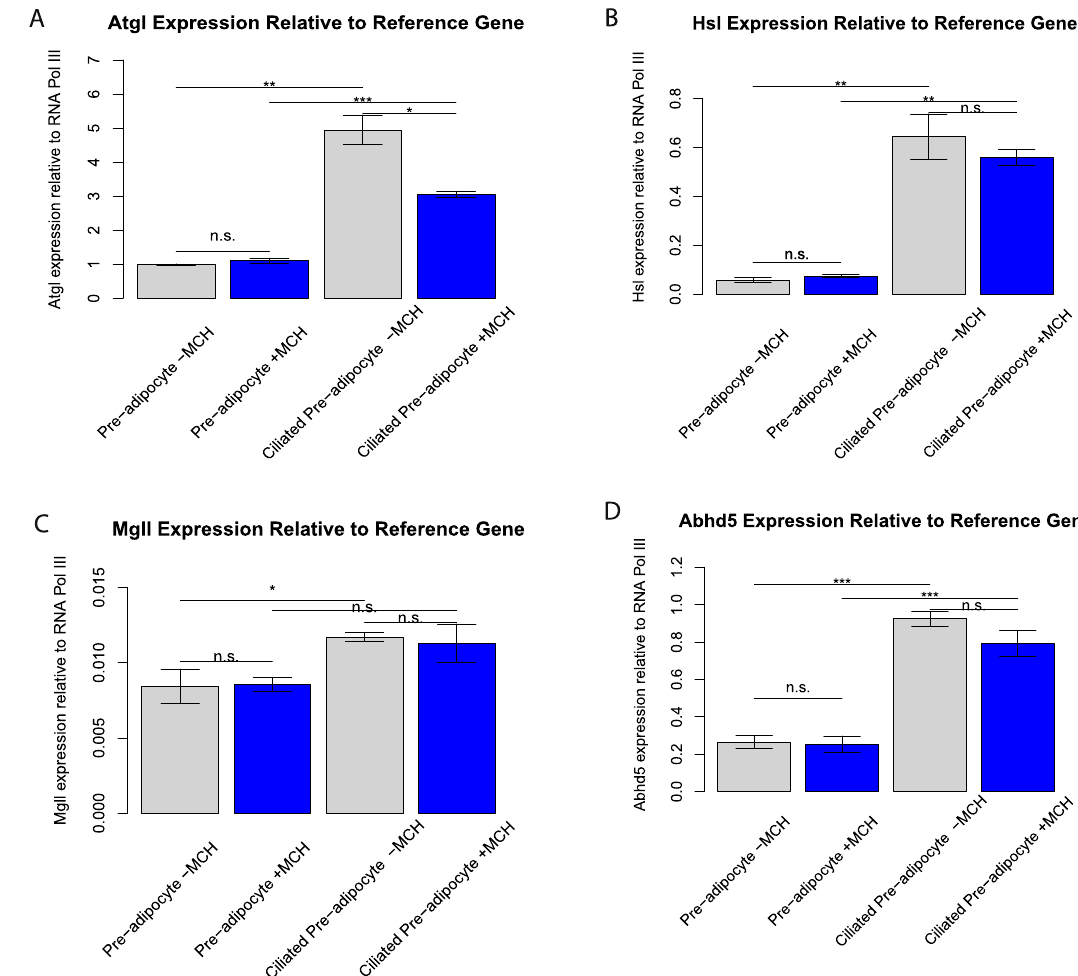
Figure 7. Expression of lipases compared to reference gene, analyzed by qPCR. ( A ) atgl expression is increased in differentiating, ciliated 3T3-L1 cells compared non-ciliated and MCH treatment significantly diminishes this upregulation ( p < 0.01). ( B ) hsl expression follows the same induction pattern as atgl , but MCH treatment doesn’t have an effect. ( C ) Expression levels of mgll are more subtly increased with the appearance of primary cilia,